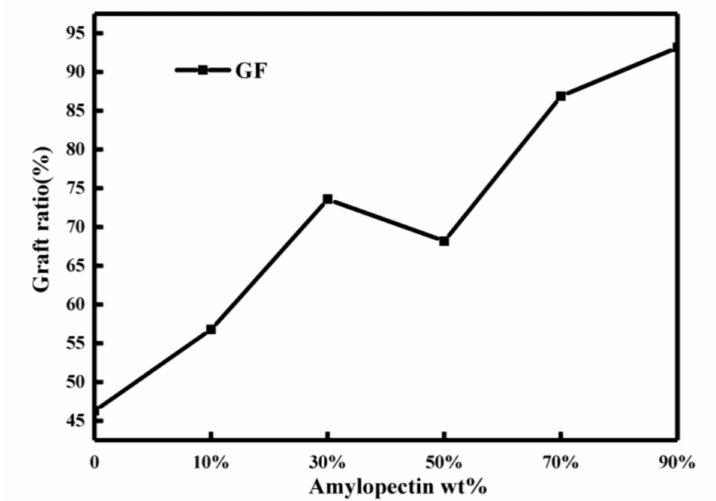
Figure 3. Grafting ratio of gel